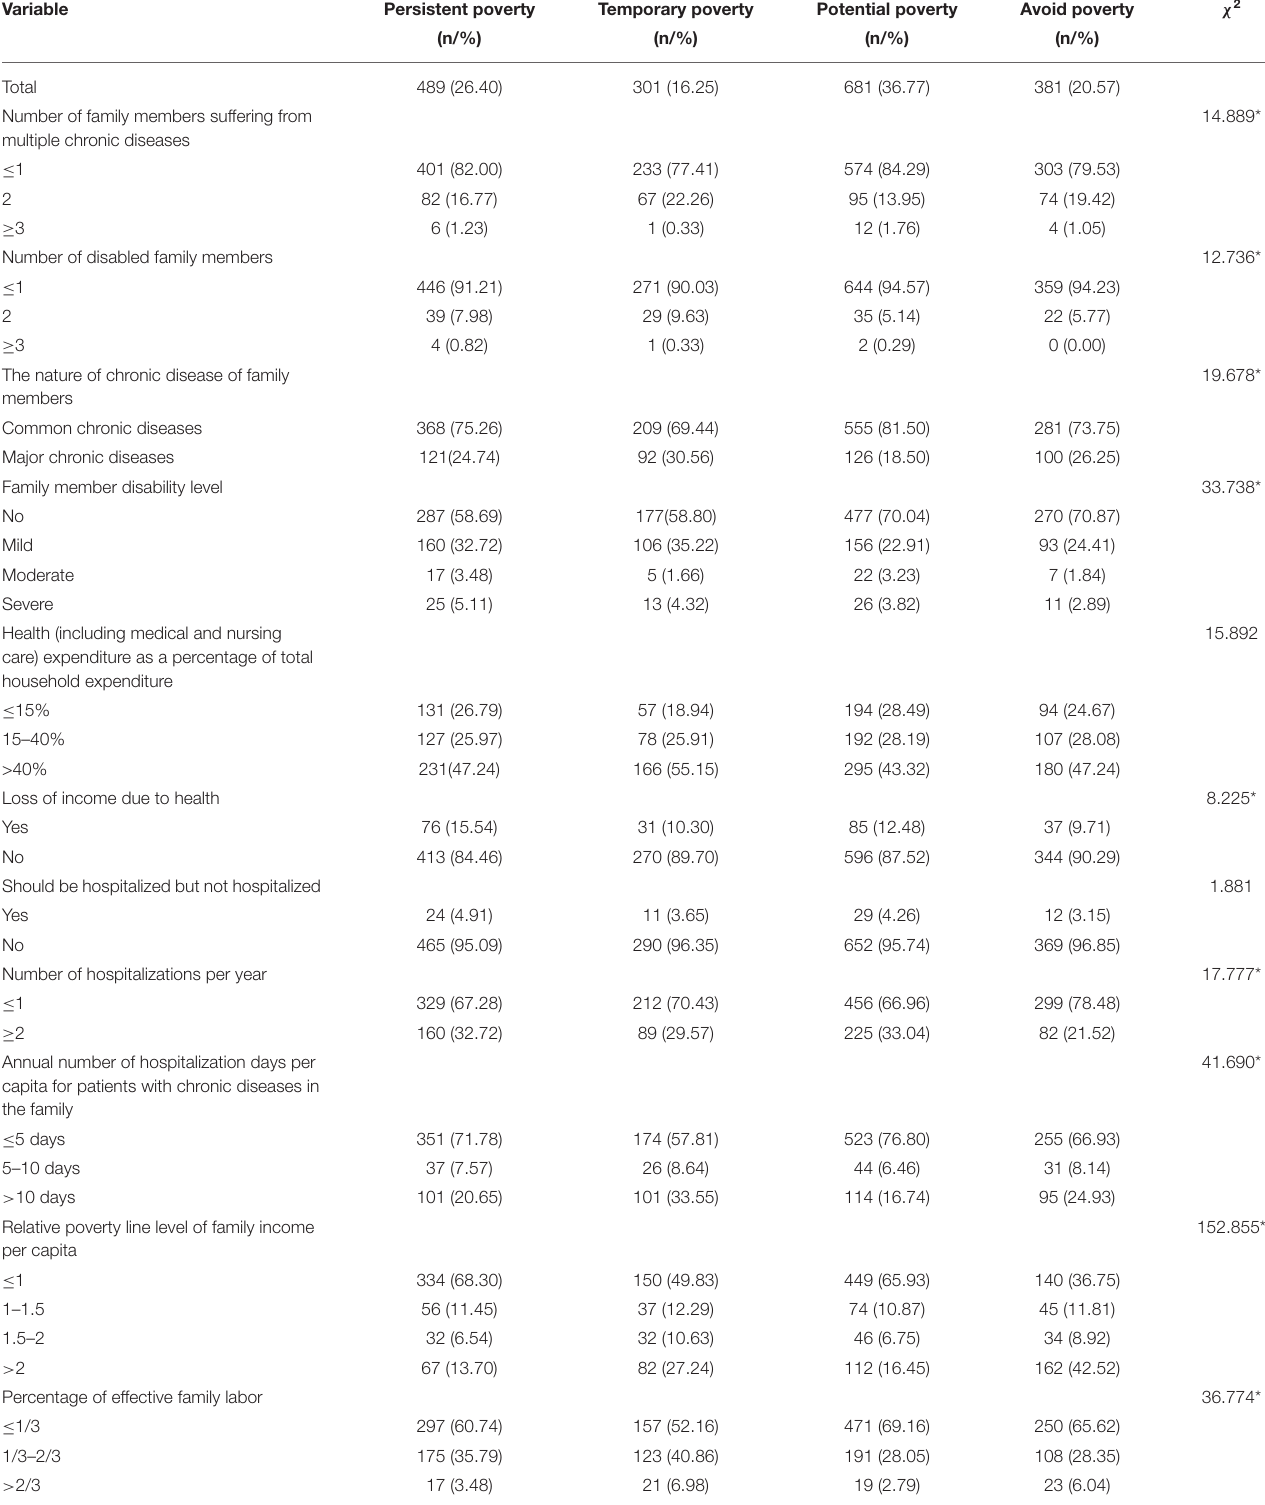
TABLE 3 | Health risk characteristics of different types of poverty